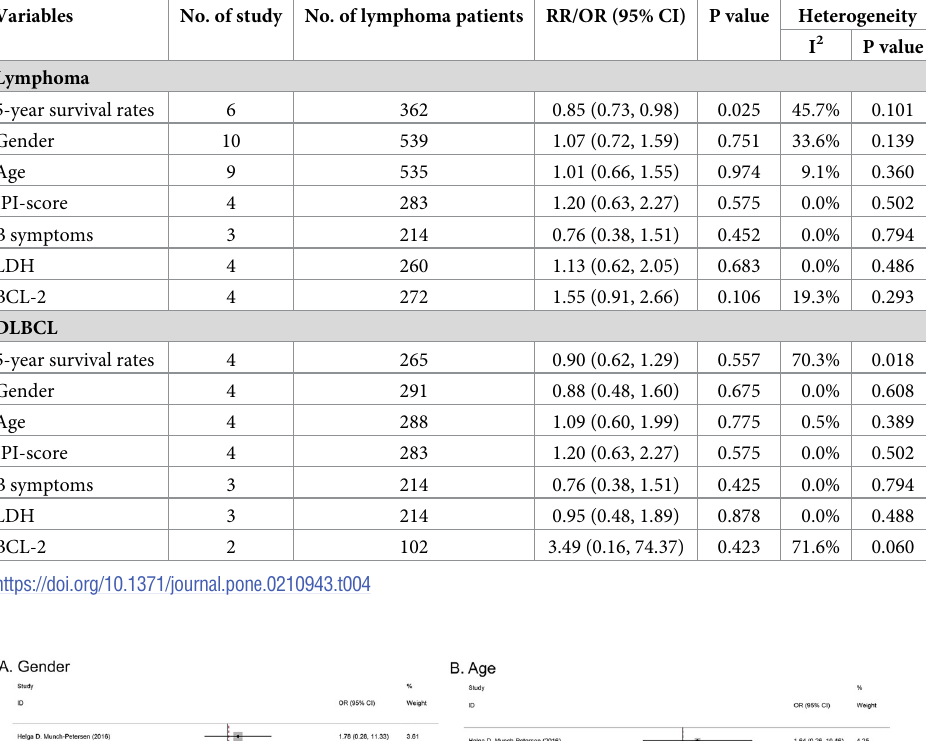
Table 4. Overall analysis of the association between DAPK methylation and clinical features of patients with lym- phoma or DLBCL.